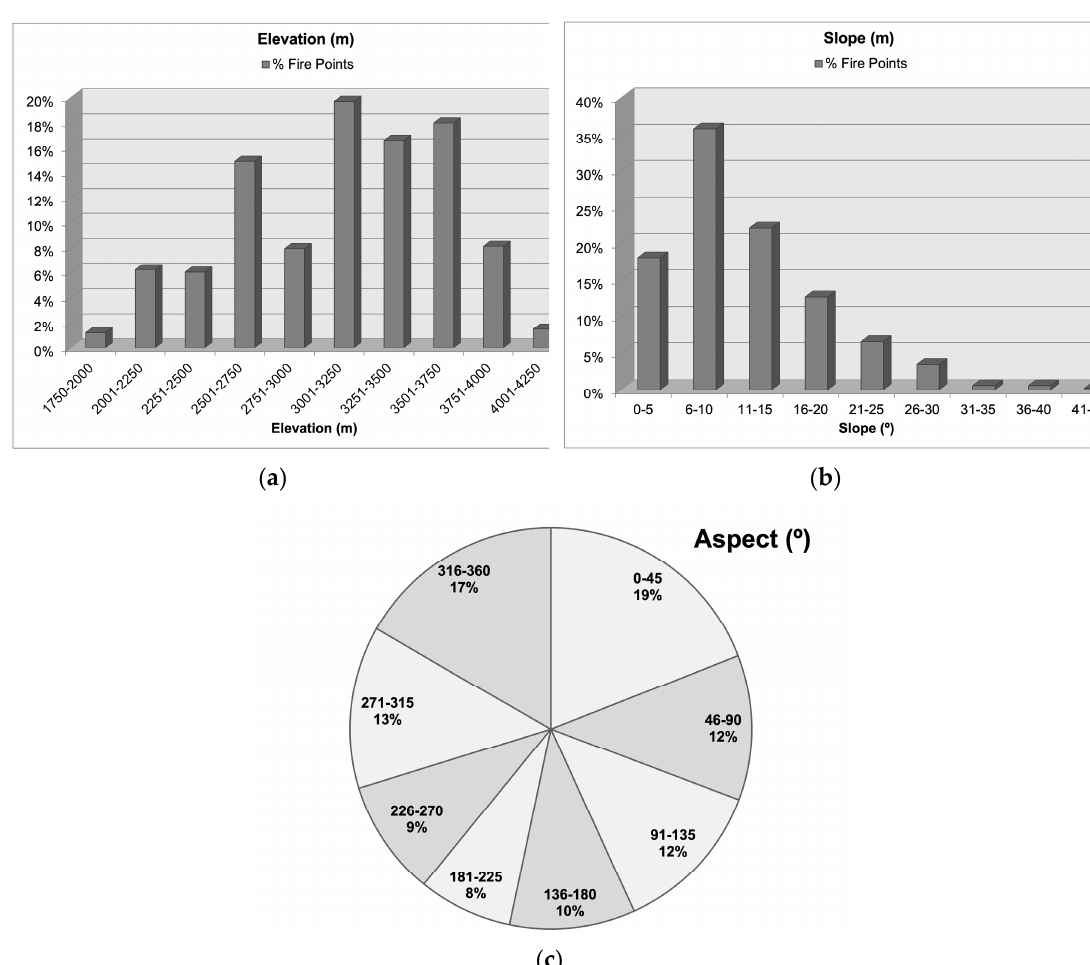
Figure 3. Proportion of MODIS active fire detection points by ( a ) elevation, ( b ) slope, and ( c ) aspect class.